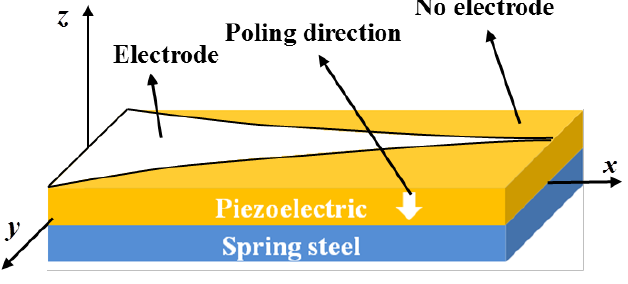
Figure 1. Scheme of the electrode of traditional mode 1 sensor with specific pattern employed for an one-dimensional cantilever